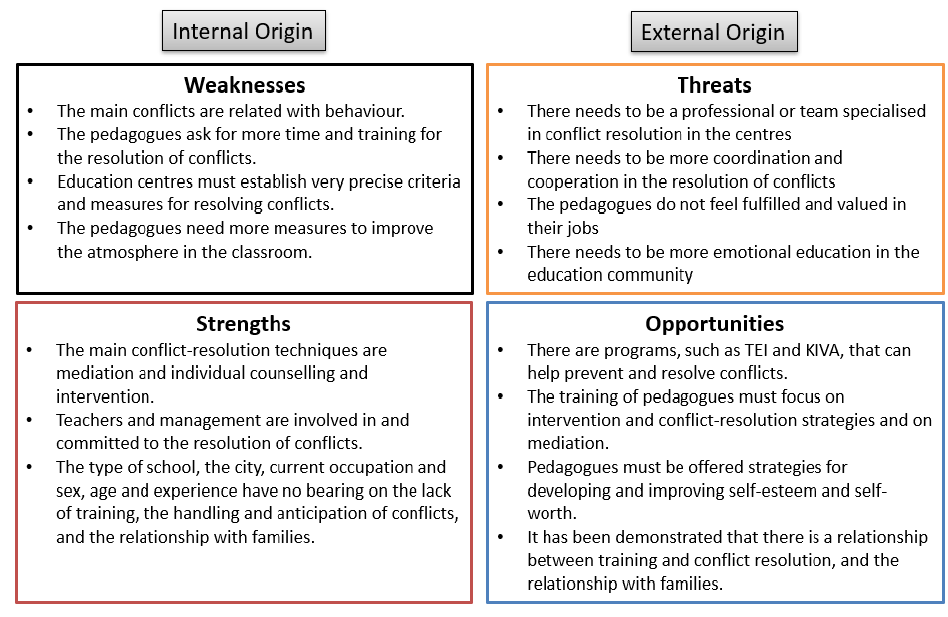
Figure 3. QUAN-QUAL integrated SWOT analysis.